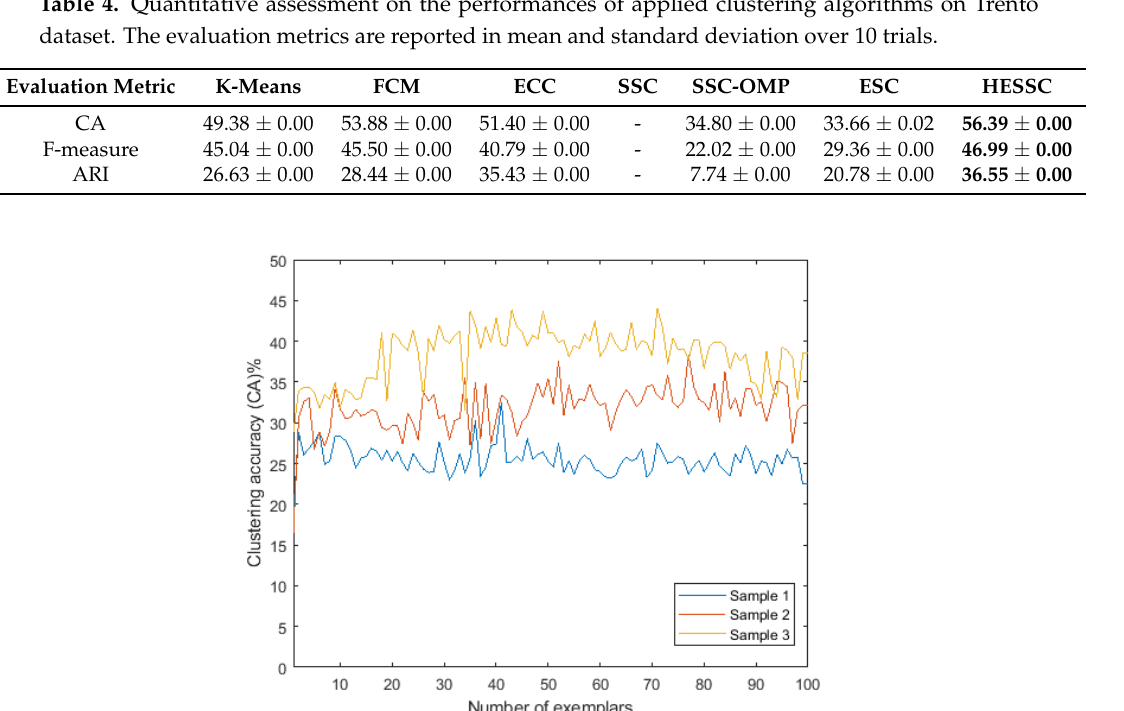
Figure 4. The clustering accuracies obtained by different numbers of exemplars ranging between {1, 2,...,y 100} using ESC for each drill-core sample. The number of exemplars with the highest CAs for each sample is chosen for further investigation. Sample 1: 41 (CA = 32.51), Sample 2: 77 (CA = 38.32), and Sample 3: 71 (CA =